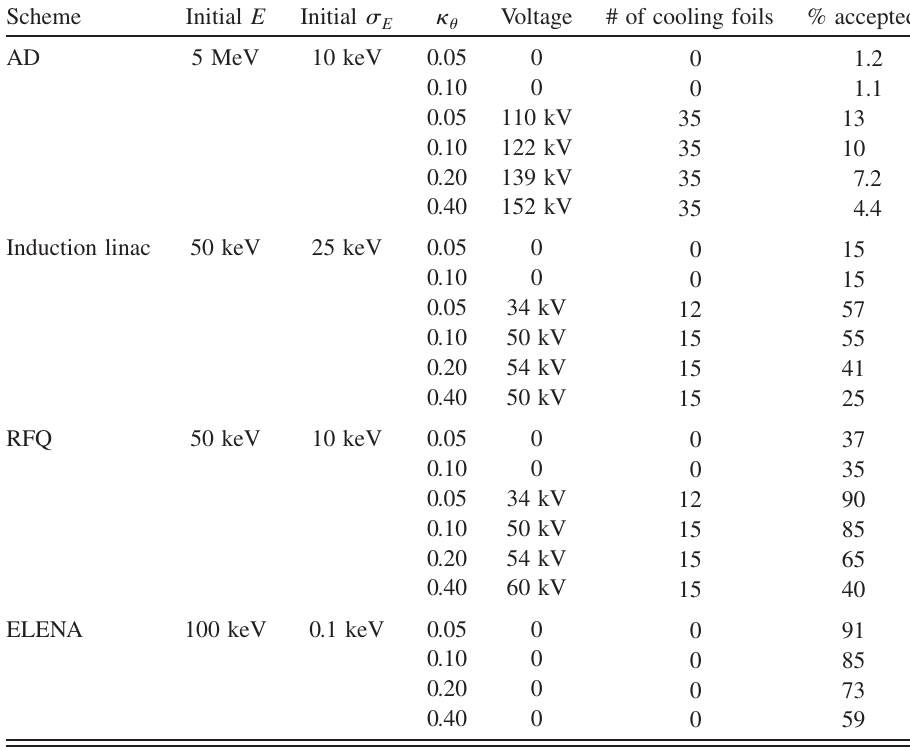
TABLE I. Numerical results of antiprotons cooling using different configurations and for different assumed values for multiple scattering strengths. The AD, induction linac, and RFQ schemes follow the indicated system with a degrading foil and possibly a frictional cooling section; the ELENA scheme is followed by a degrading foil